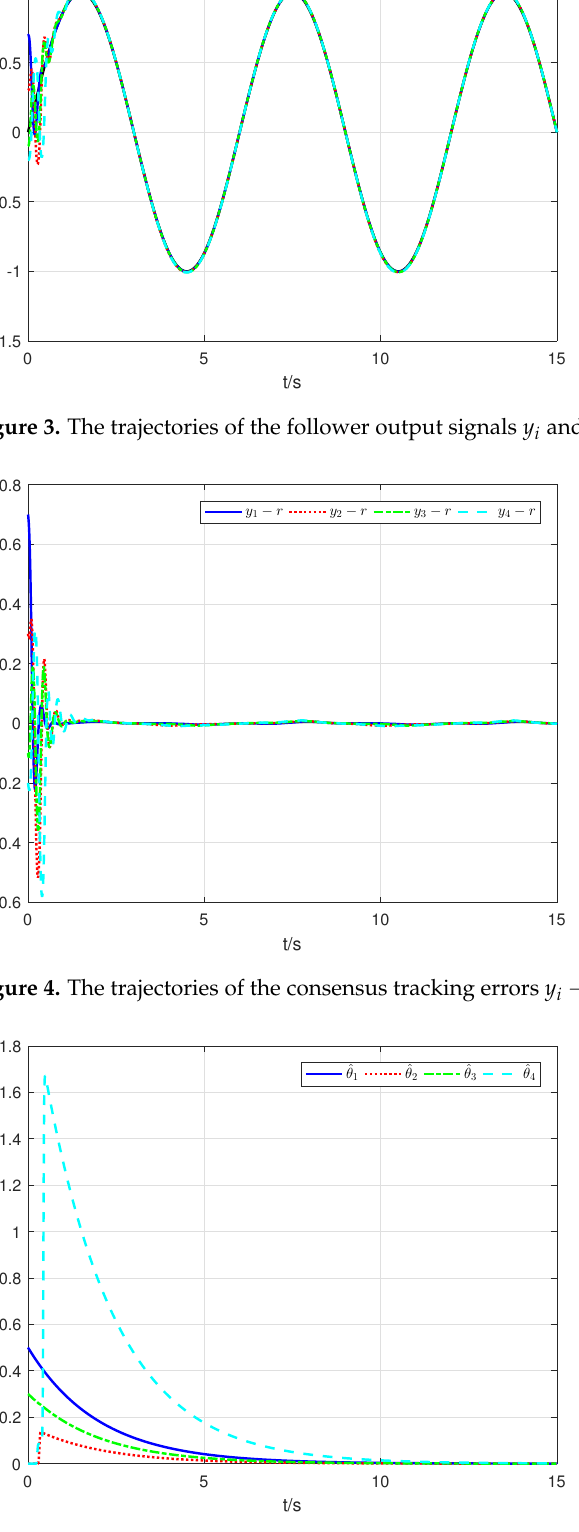
Figure 5. The trajectories of the adaptive laws ˆ θ i